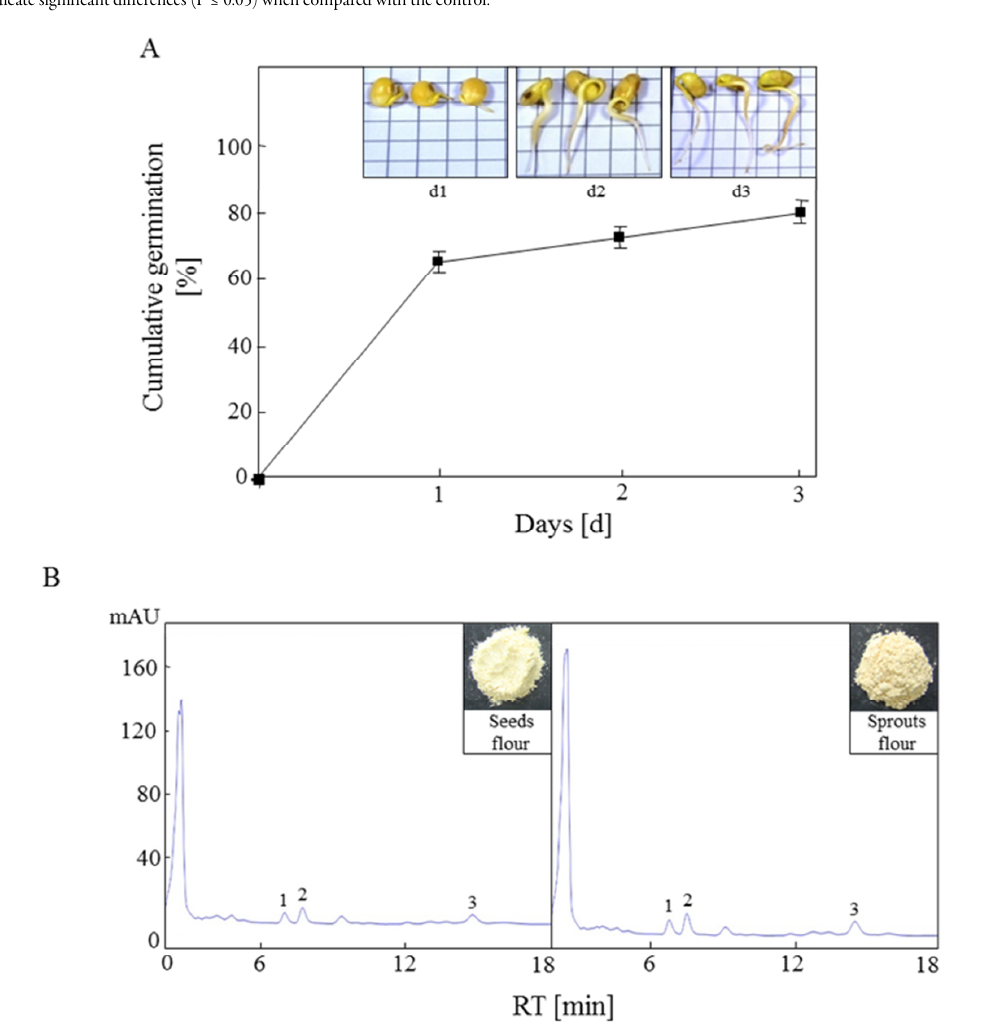
Fig. 4. Effect of sprouting on total and individual aglycone IF components of soybean; A. Cumulative germination (%) was measured over a test-period of 3 d following 4 h of priming in water. Means ± SDs, n = 3 , with 50 seeds per measurements. Inset depicts the representative images of temporal sprouts formation during the assay-period; B. Representative HPLC chromatograms showing the separation of ethanol soluble and acid-hydrolysable IF extracts from mature seed- ( left-panel ) and sprout-flours ( right-panel ) at 3 days of germination. The individual aglycone from each sample was evaluated by peak identification with overlapping retention time (min) of corresponding aglycone standard. Inset shows the soybean flours prepared from the seeds and sprouts at 3 days of